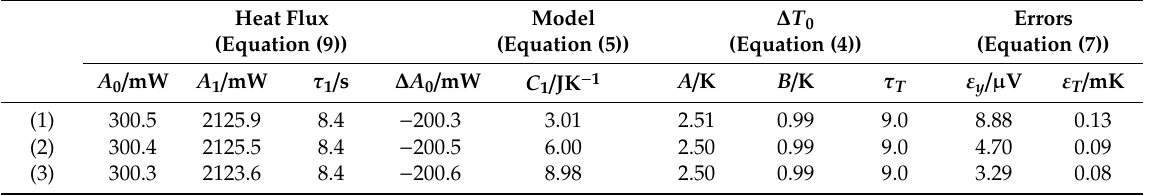
Table 2. Results of the calculation on the simulated measurements with C 1 = 3, 6 and 9 JK − 1 (Figure 8).